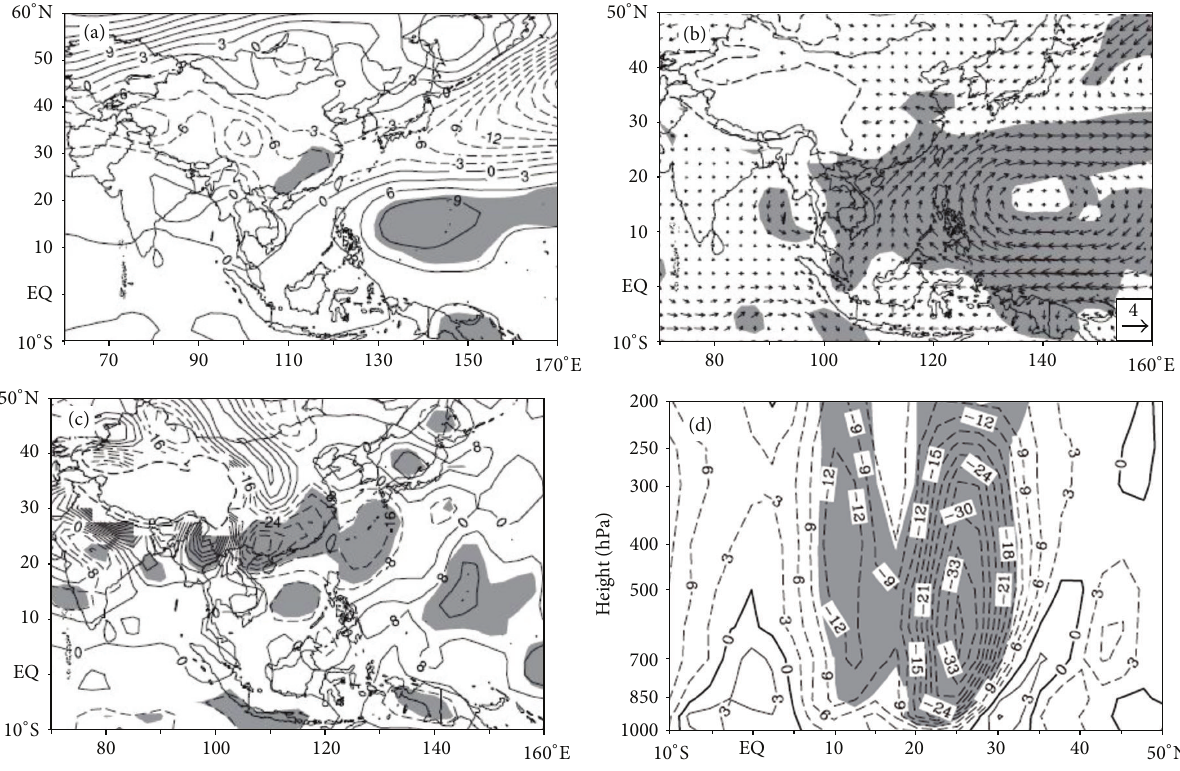
Figure 10: The differences of physical fields between the abundant spring precipitation years and scarce precipitation years in the South China: (a) the 500 hPa geopotential height (dagpm); (b) the 850 hPa wind (ms −1 ); (c) the low-level convergence (10 −3 s −1 ); and (d) the zonally averaged (along 110 ∘ –120 ∘ E) vertical velocity in p-coordinate (10 −3 Pas −1 ).